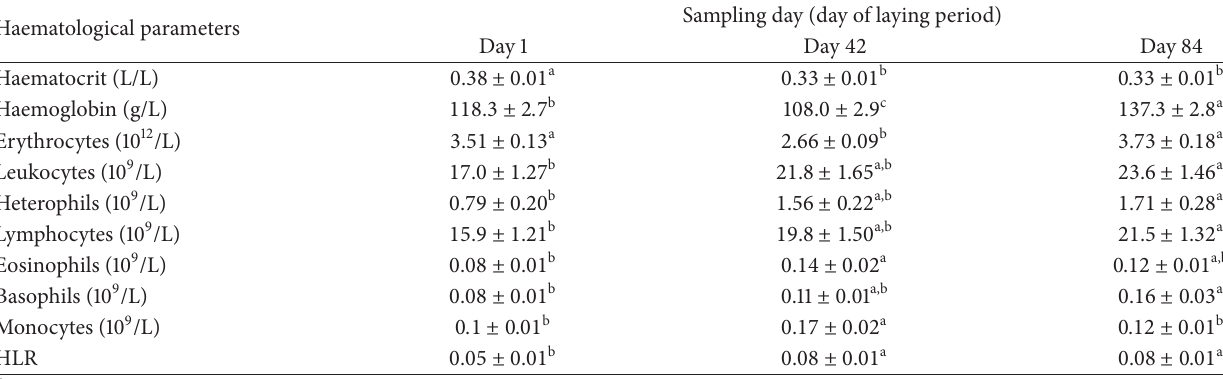
Table 1: Haematological parameters in pheasant hens ( 𝑛 = 15 /group) housed in an enhanced cage system during the laying period (means ±